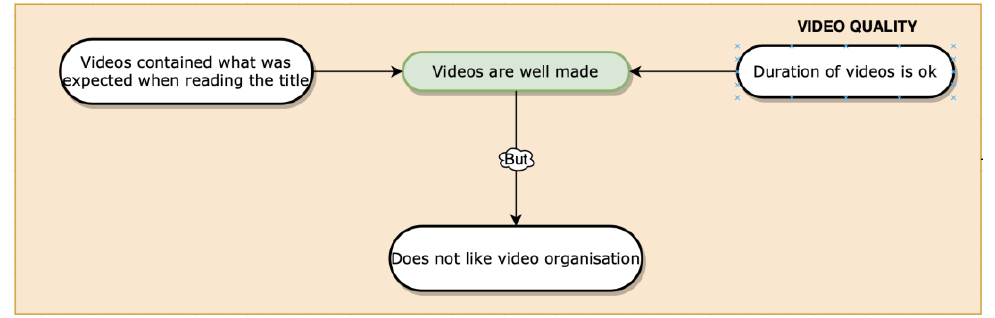
Figure 6. Enlargement of the box “ video quality ” .